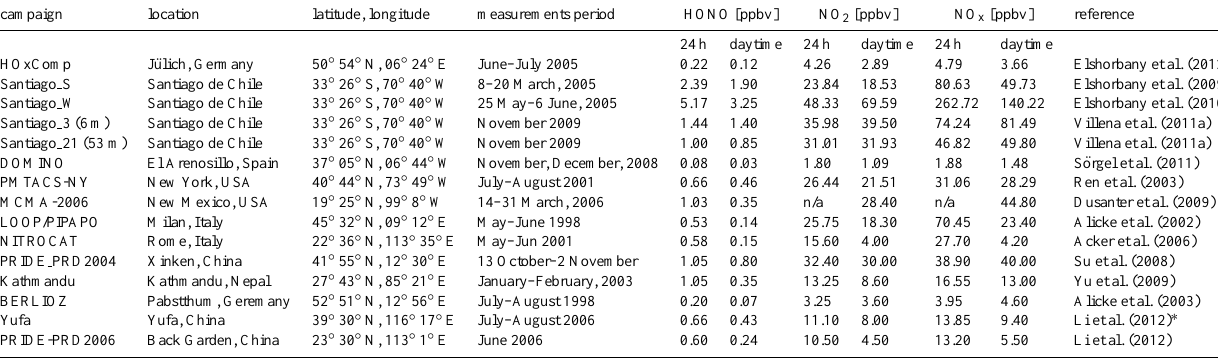
Table 1. Summary of the field measurement data sets used. campaign